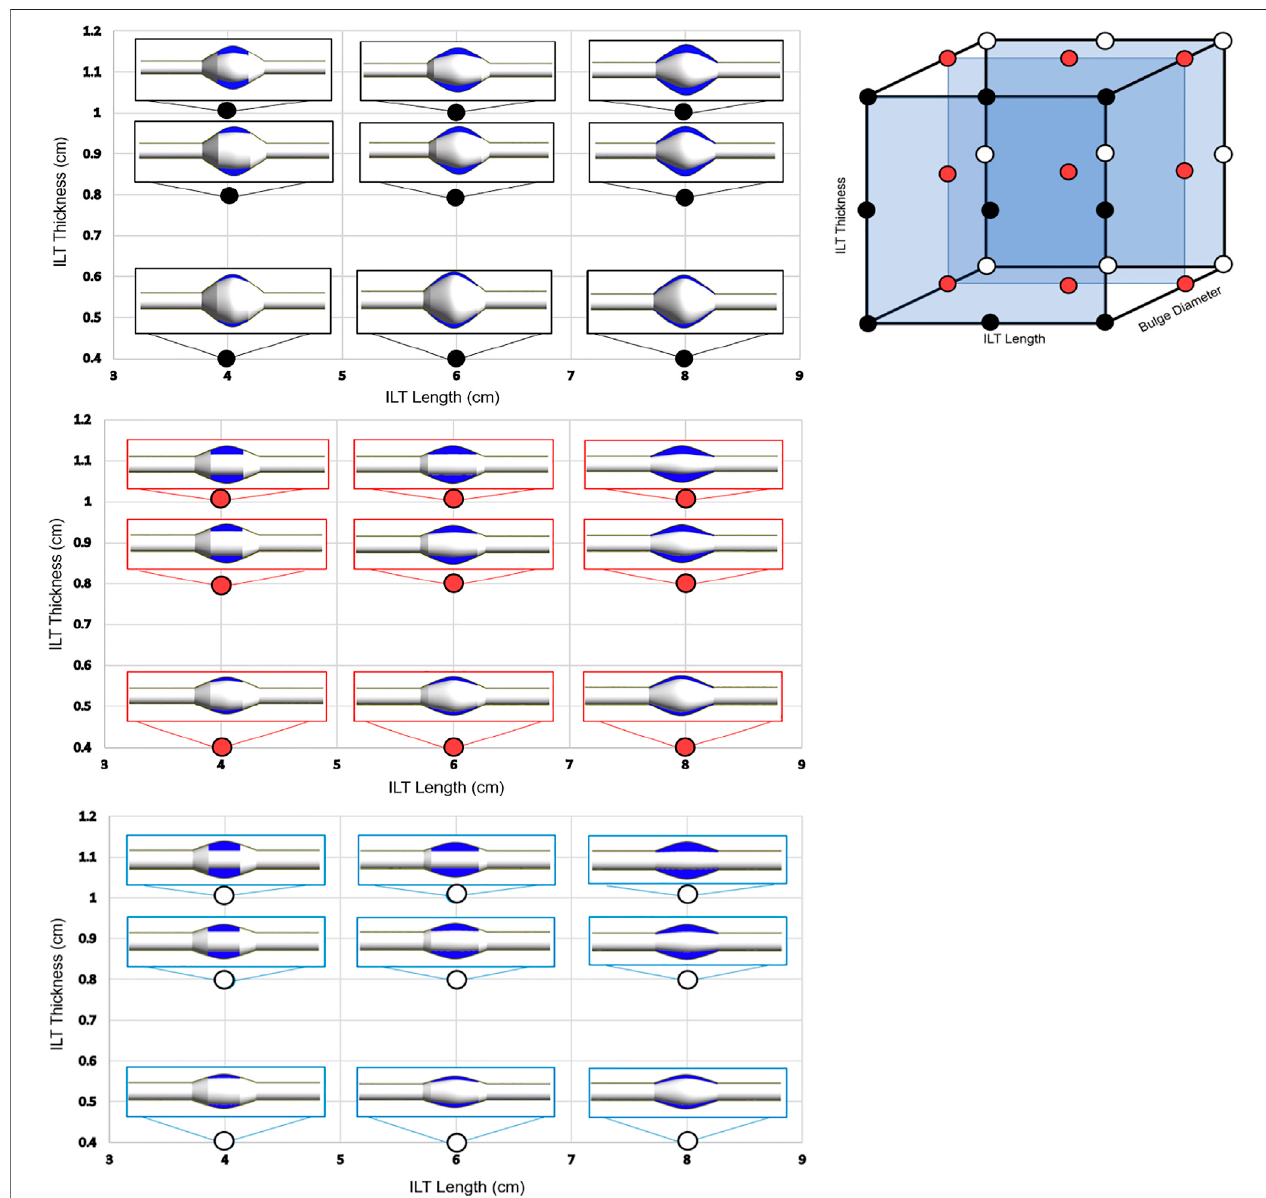
FIGURE 2 | The 3-dimensional visualization of the parametric space is shown (top-right), where each point represents one of the twenty-seven AAA geometries used in this study. Each case is characterized by a variation in ILT length, bulge diameter, and ILT thickness identi fi ed on one of the three axes, respectively. The cases are divided into three groups of nine AAA models based on bulge diameter, denoted by black ( BD = 7 cm), red ( BD = 5.2 cm), and white ( BD = 4.2 cm) points on the 3D parametric space cube. The three 2D plots (left) illustrate the anatomic variations on three planes of constant BD , and each plane shows combined variations in thickness and length of the ILT lesion. Individual cases were designed to have ILT length of 4 cm, 6 cm, or 8 cm, and an ILT thickness of 0.4, 0.8, or 1 cm. These cases will serve as the basis of comparison for differences oxygen concentration among the simulations.